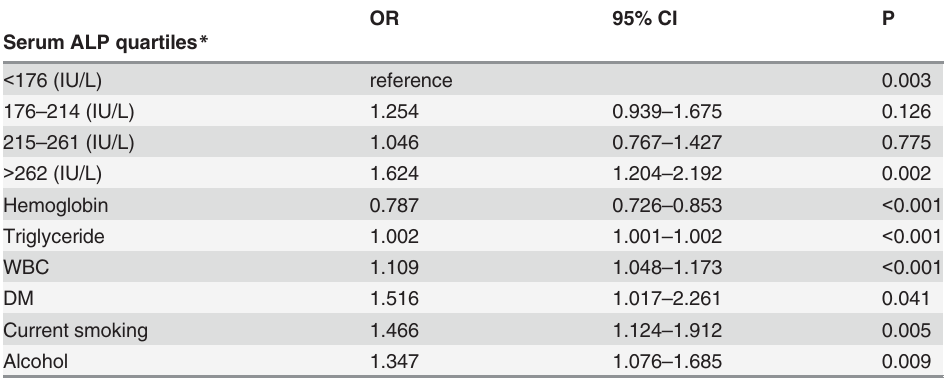
Alcohol 0.009 * The odds ratios of serum alkaline phosphatase quartiles were adjusted by age, sex, diastolic blood pressure, glucose, body mass index, alanine aminotransferase, aspartate aminotransferase, hemoglobin, white blood cell count (WBC), ferritin, triglyceride, diabetes (DM), metabolic syndrome, angina, current smoking, and alcohol